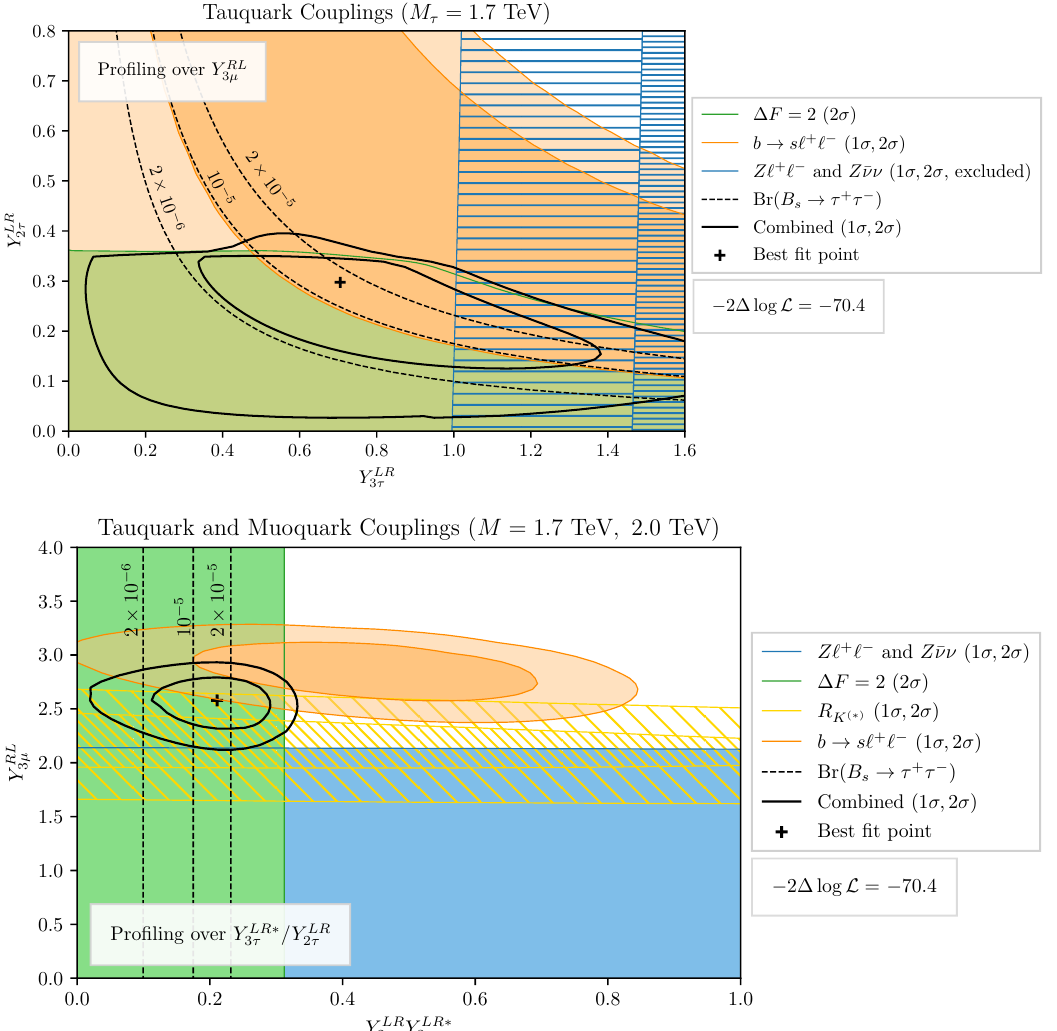
and Y LR derived from the combined fit of Φ 2 ,τ 3 τ 2 τ coupling. The coupling Y LR is tightly constrained by 3 µ 2 τ ¯ values worsen the fit to B B s mixing (green as well) s − 3 τ . We profile over the ratio Y LR ∗ that is relevant /Y LR 3 µ 3 τ 2 τ